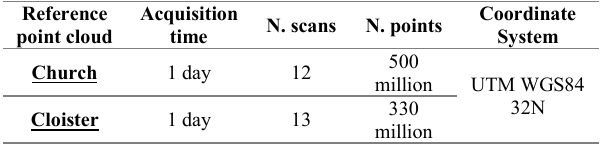
Figure 5. The reference LiDAR point clouds of the Church and Figure 4. The test paths: in red, the first trajectory followed the Cloister. inside the Curch; in blue, the path defined through the corridor Table 1. Characteristics of the obtained reference point and along the cloister. (S) and (E) represent, respectively, the start and end point.